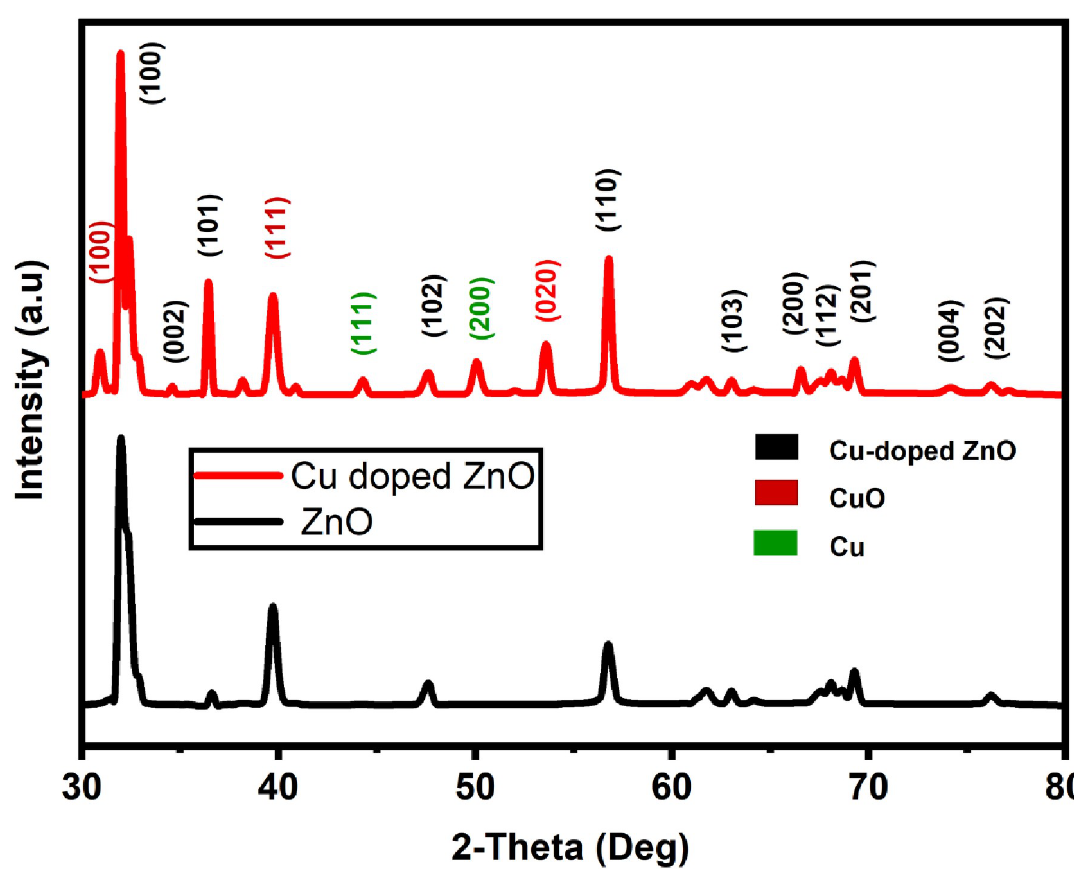
Fig 4. XRD pattern of Cu-doped ZnO nanoparticles showing peaks for different contents in the sample. https://doi.org/10.1371/journal.pone.0251082.g004 microbes, S . aureu s forms a ZOI of 24 ± 0.20 mm, whereas S . pyogenes form a ZOI of 20 ± 0.14 mm on the same dose. Among gram-negative microbes, E . coli display 18 ± 0.11 mm ZOI, whereas, the K . pneumonia forms 17 ± 0.13 mm ZOI as shown in Table 1 . All the results were